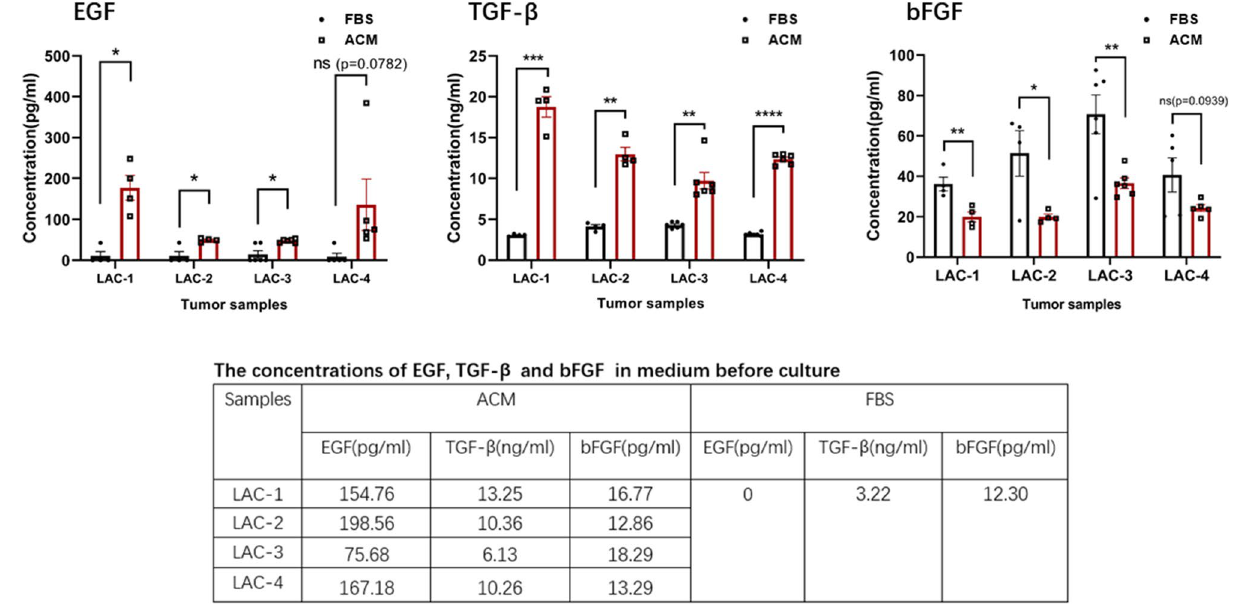
Figure 4. Differences in growth factors between ACM and FBS cultures. ELISA for EGF, TGF-b and bFGF concentrations in media from four LAC (pleural effusions) cultures. Media were collected after 10–15 days in culture. Concentrations are means of 4–6 wells/sample. The concentrations are shown in the columns: red for ACM and black for FBS. The numbers of culture wells/sample are indicated by square dots for ACM and by triangles for FBS. Inserted table shows the concentrations of these growth factors in intact ACM and FBS media (the FBS medium was the same for all culture wells). The difference between ACM and FBS for an individual sample was analyzed with student t -test: * < 0.05 , ** p < 0.01 , *** p < 0.001, and **** p < 0.0001. The differences between ACM and FBS as a group for each growth factor were also analyzed with one way ANOVA, p ≤ 0.001 for all three groups. Tests were repeated 2 or 3 times, with similar